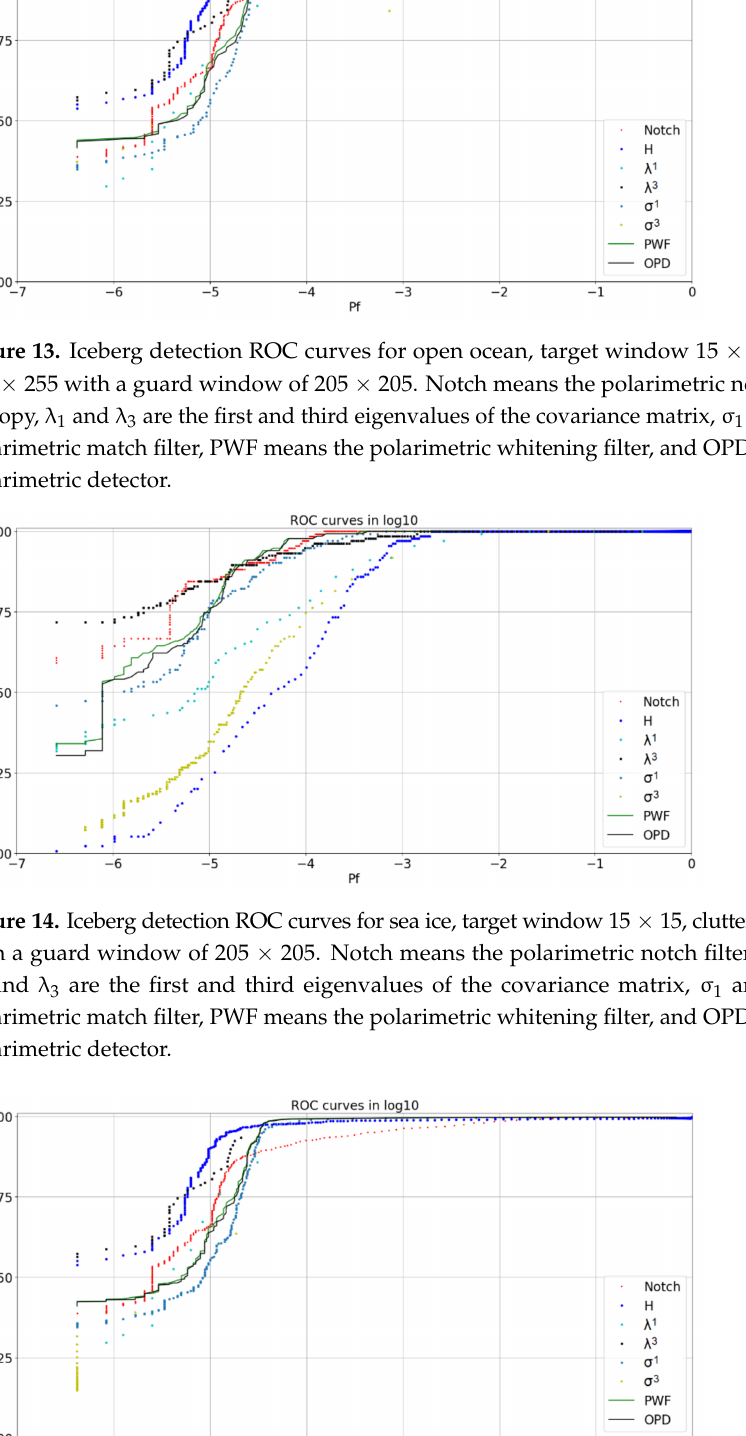
Figure 15. Iceberg detection ROC curves for open ocean, target window 5 × 5, clutter window 105 × 105 with no guard window. Notch means the polarimetric notch filter, H means entropy, λ λ 1 and 3 are the first and third eigenvalues of the covariance matrix, polarimetric match filter, PWF means the polarimetric whitening filter, and OPD means the optimal polarimetric